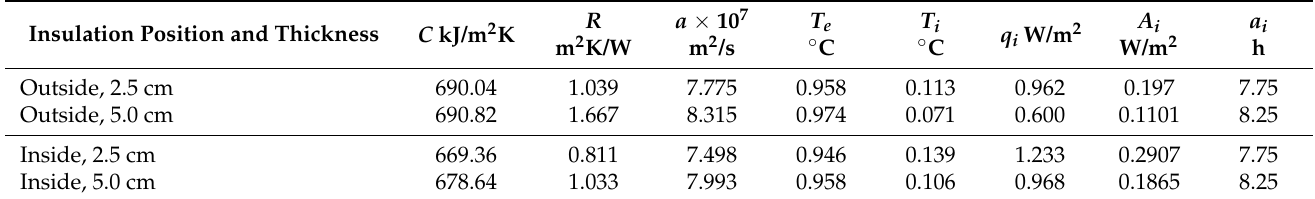
Table 5. Effect of insulation thickness and location of the EIFS walls on the thermal bridge between floors using the standard